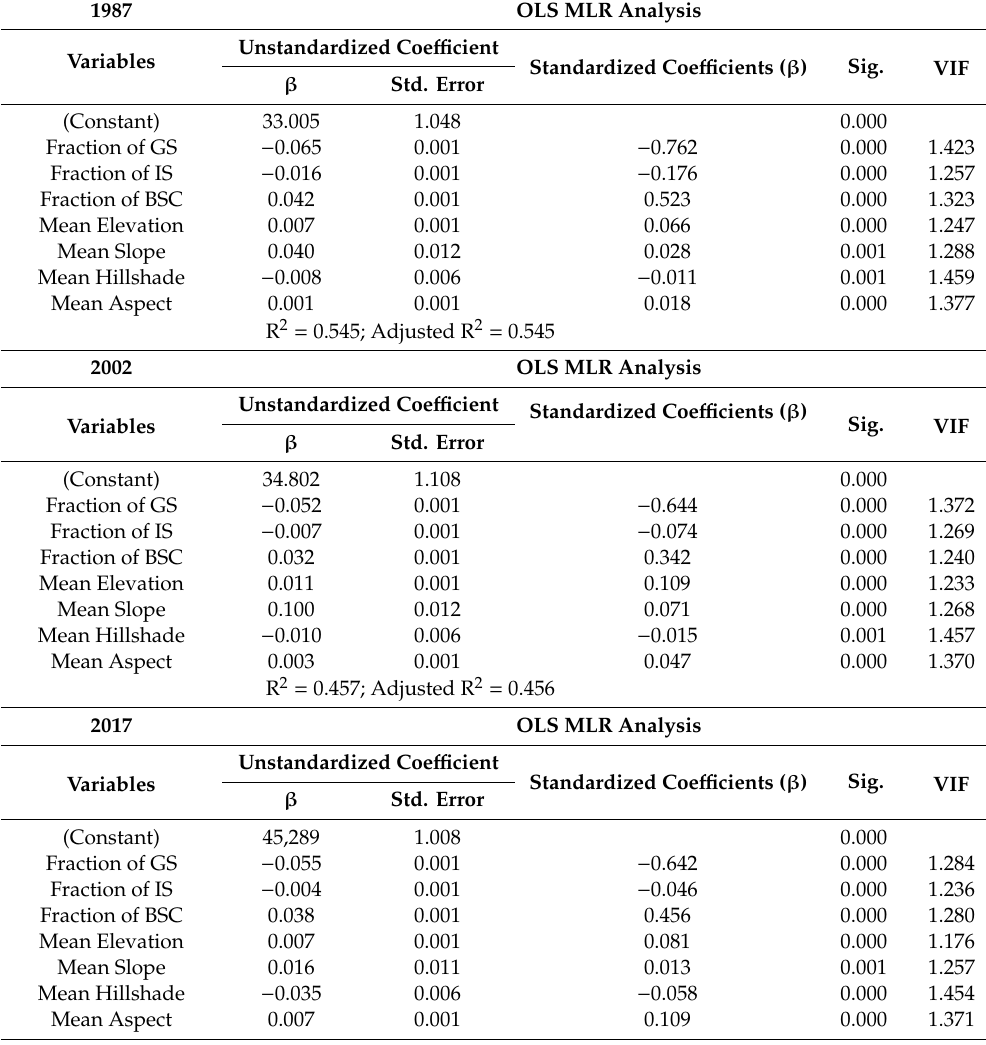
Table 2. Result of the OLS MLR analysis (Dependent Variable: Mean LST; N = 9216).